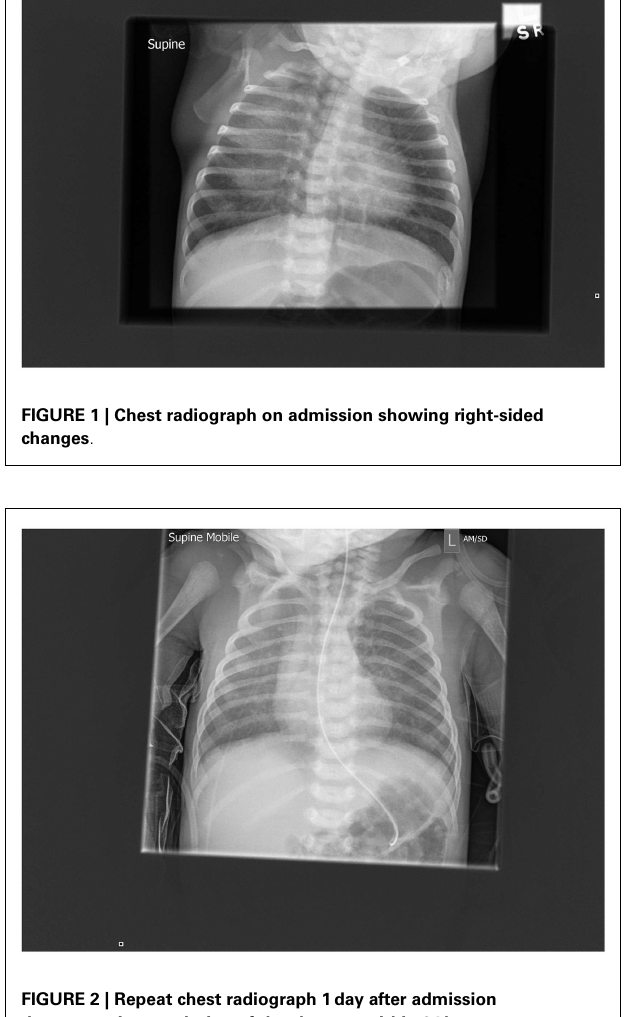
FIGURE 2 | Repeat chest radiograph 1day after admission demonstrating resolution of the changes within 24h .